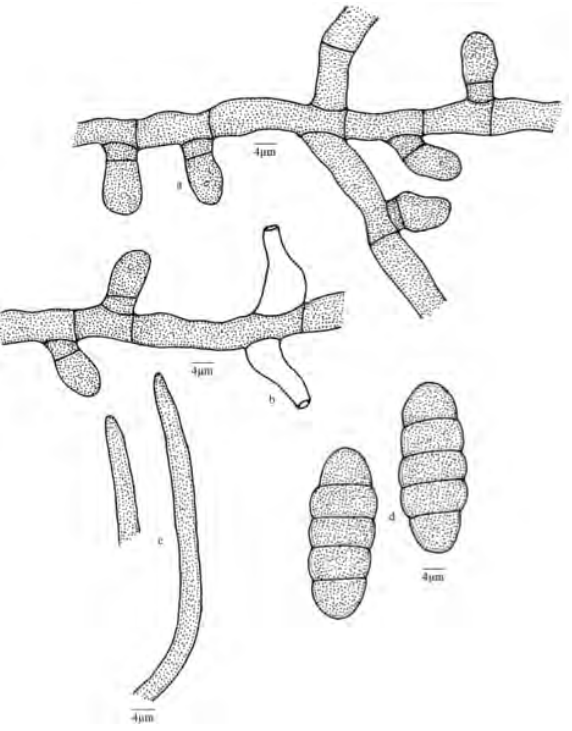
Figure 69. Meliola densa a - Appressorium; b - Phialide; c - Apical portion of mycelial setae; d -